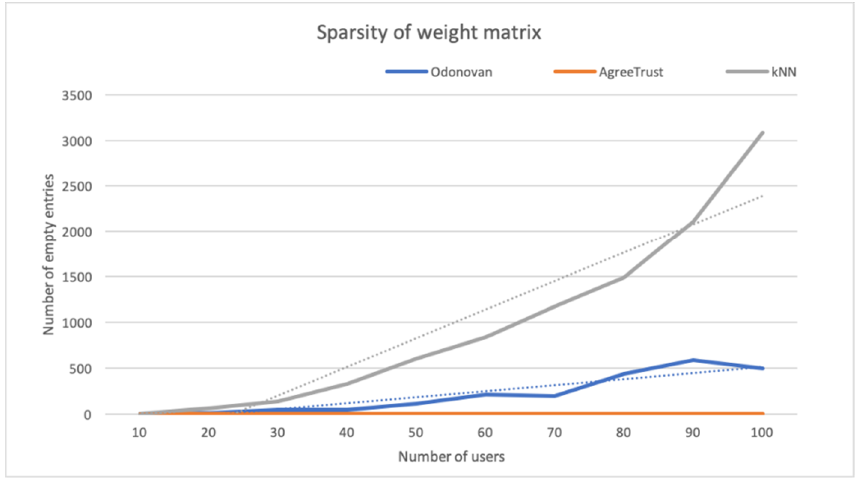
Figure 4. Sparsity of the weight matrices versus number of users.